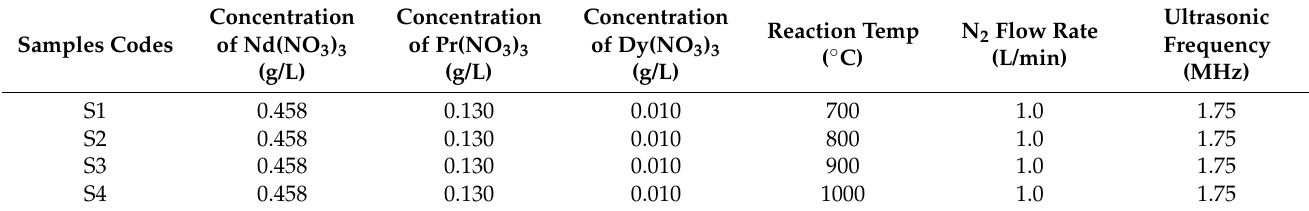
Figure 2. One step ultrasonic spray pyrolysis lab-scale horizontal equipment: ( a )—gas flow regulation; ( b )—ultrasonic aerosol generator; ( c )—furnace with the wall heated reactor; ( d )—collection bottles; e—gas inlet, f—gas outlet. Table 1. Experimental parameters of ultrasonic spray pyrolysis